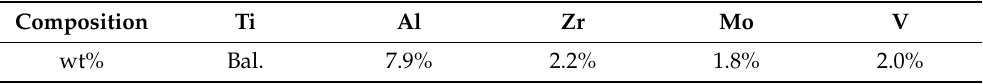
Table 1. The composition of the printed material, determined by EDS.